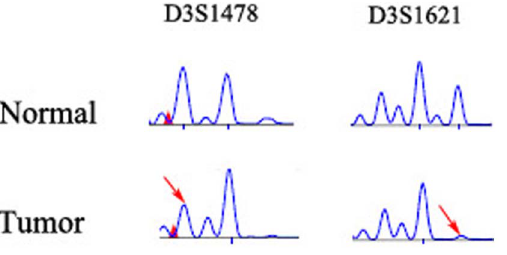
Figure 2. Representative results of detection of LOH in salivary adenoid cystic carcinoma. The markers D3S1478, D3S1621 flanking 3p21 regions were analyzed. Arrows indicate alleles that showed LOH in the tumor